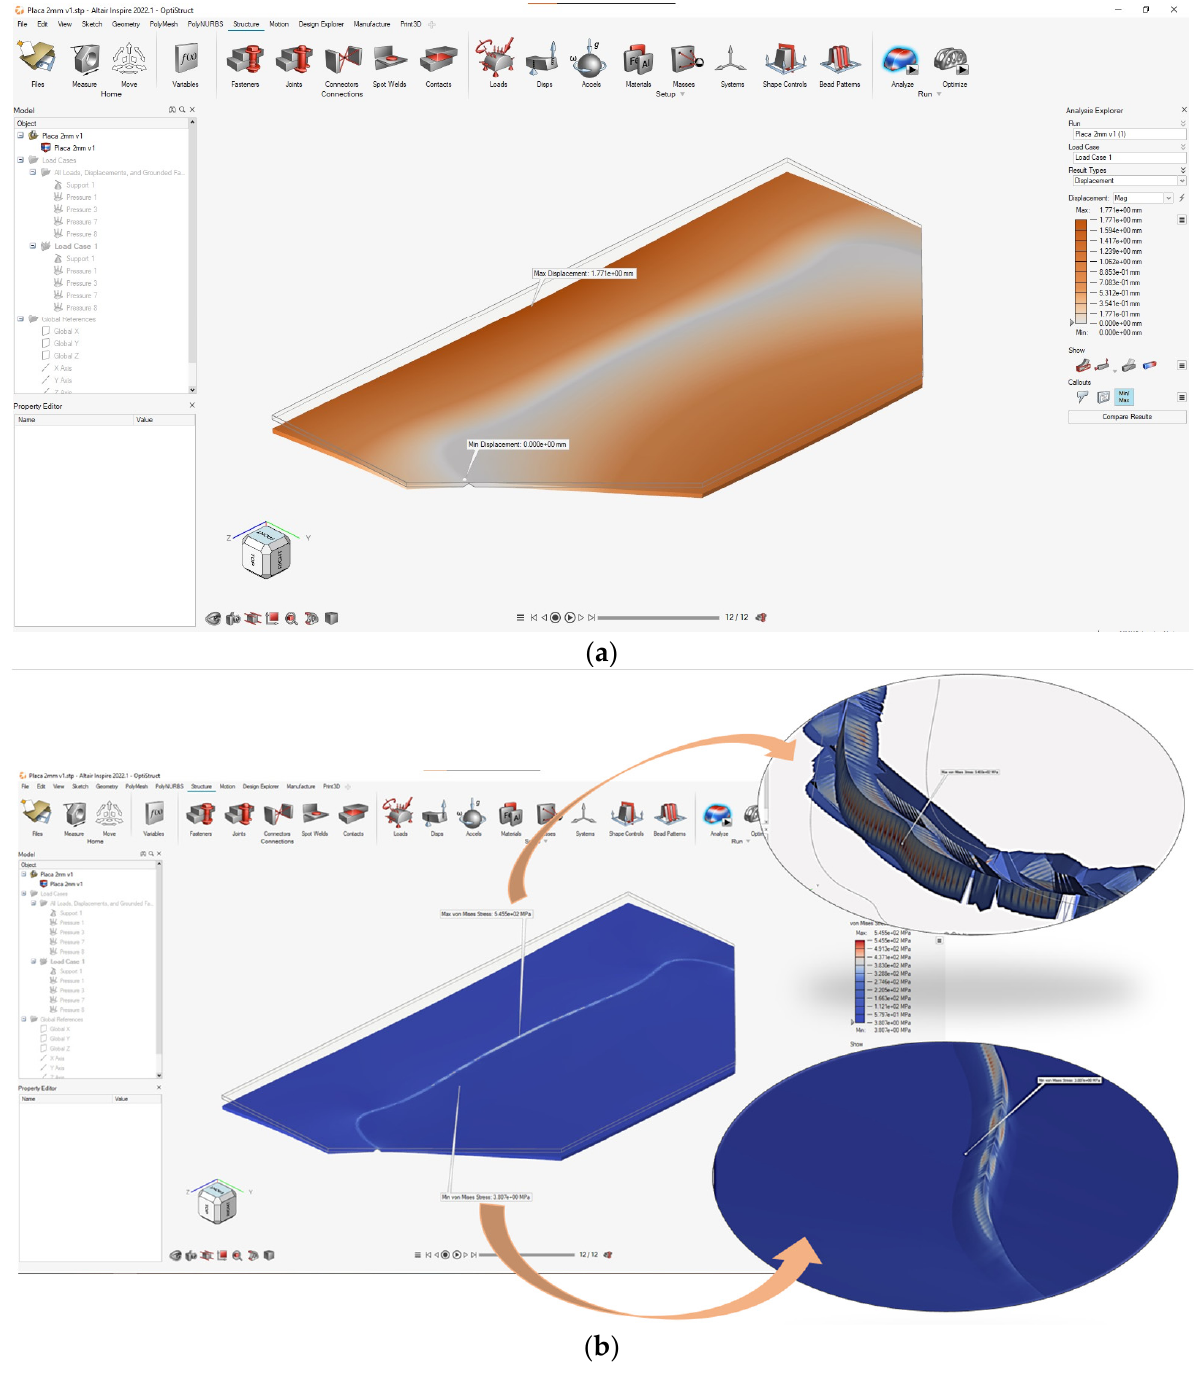
Figure 34. The model no. 5: ( a ) deformations; ( b ) von Mises equivalent